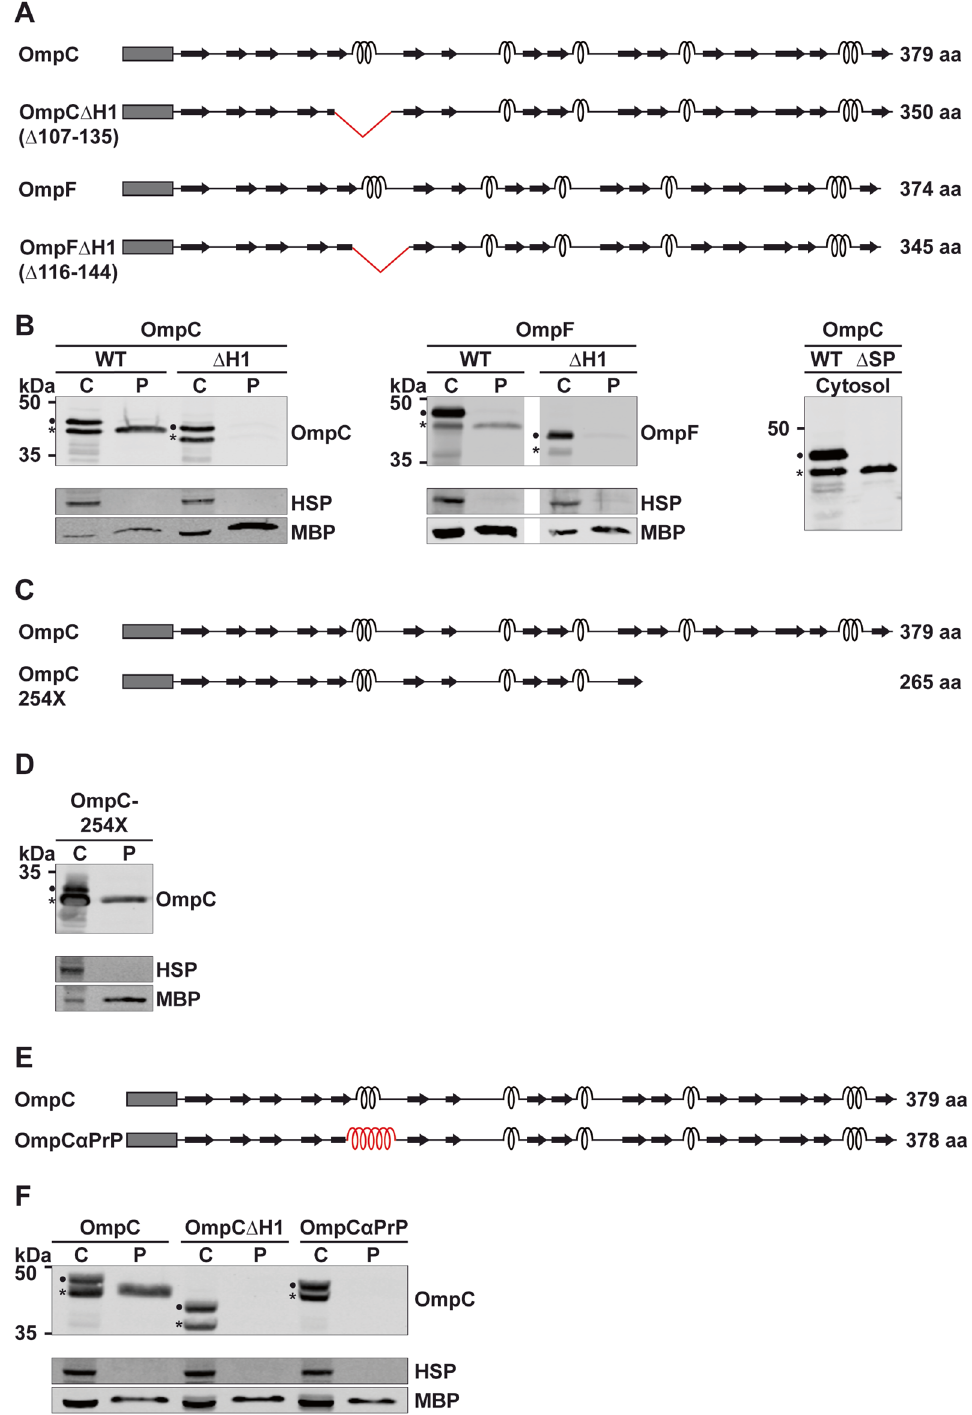
Figure 1. A conserved alpha-helical domain is critically required for periplasmic localization of OmpC and OmpF. ( A , C , E ) Schematic presentation of the constructs analyzed. Dark rectangle: signal peptide; arrows indicate beta-strands, α-helical structure is indicated by helices, the α-helical domain derived from PrP is shown in red (E); amino acids deleted are shown by red triangle and listed below protein name. The total length of the proteins is indicated. ( B , D , F ) Transformed E. coli cells expressing the proteins indicated were fractionated and the cytoplasmic (C) and periplasmic (P) fraction analyzed by Western blotting. Unprocessed full length constructs ( ) and constructs after signal peptide cleavage (*) are marked. Cytosolic heat shock proteins (HSP) and the periplasmic maltose-binding protein (MBP) were analyzed in parallel. Uncropped images of ● representative Western blots can be found in Supplementary Figures 1 and